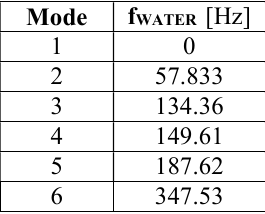
Table 2 Natural frequencies of runner submerged in water